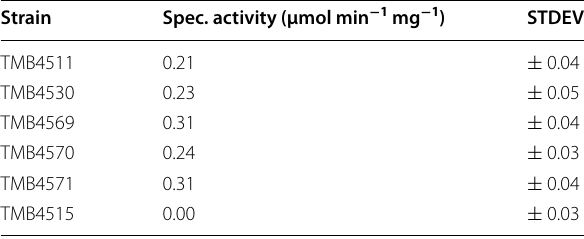
The enzymatic activity of XylB that catalyzes the conversion of d -xylose into d -xylono-γ-lactone was assayed in five strains including: TMB4511 (XylB, XylC), TMB4530 (XylB, Cc XylD, XylX, XylA), TMB4569 (XylB, Bc XylD, xylX, xylA), TMB4570 (XylB, Ec YjhG_Ec, XylX, XylA) and TMB4571 (XylB, El XylD_El, xylX, xylA). As a control strain, TMB4515 that contains only the lower part of the pathway including Cc XylD, XylX and XylA was used